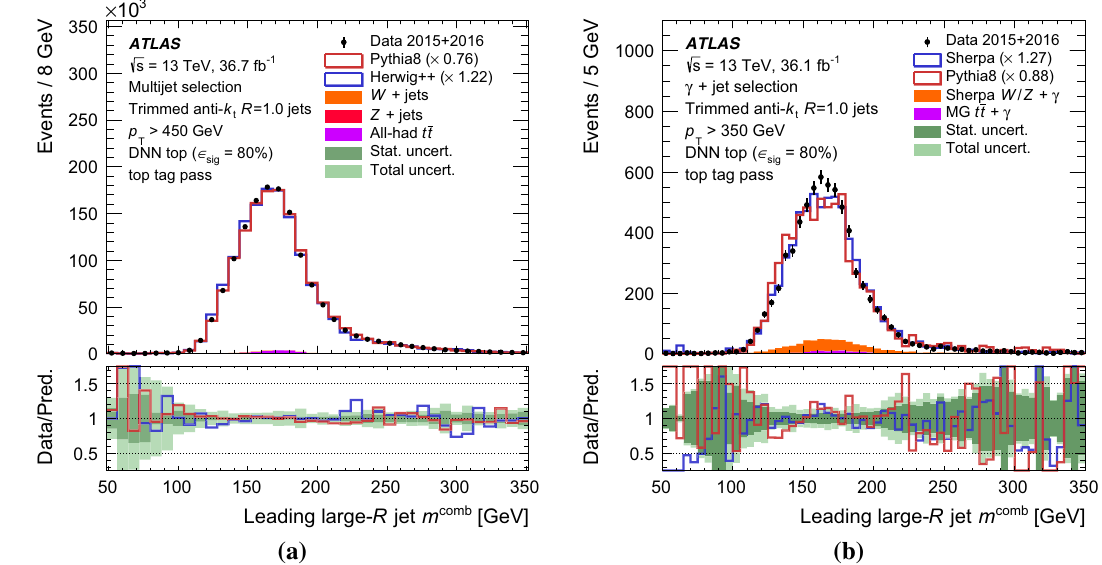
Fig. 32 A comparison of the observed data and predicted MC distri- butions of the anti- k t R = 1.0 trimmed jet m comb observable for events from the multijet ( a ) or γ + jet ( b ) selections that pass the selection on the jet-shape-based top quark DNN tagger. The data-driven nor- malisation correction, described in Sect. 6.2.1, is shown in the legend